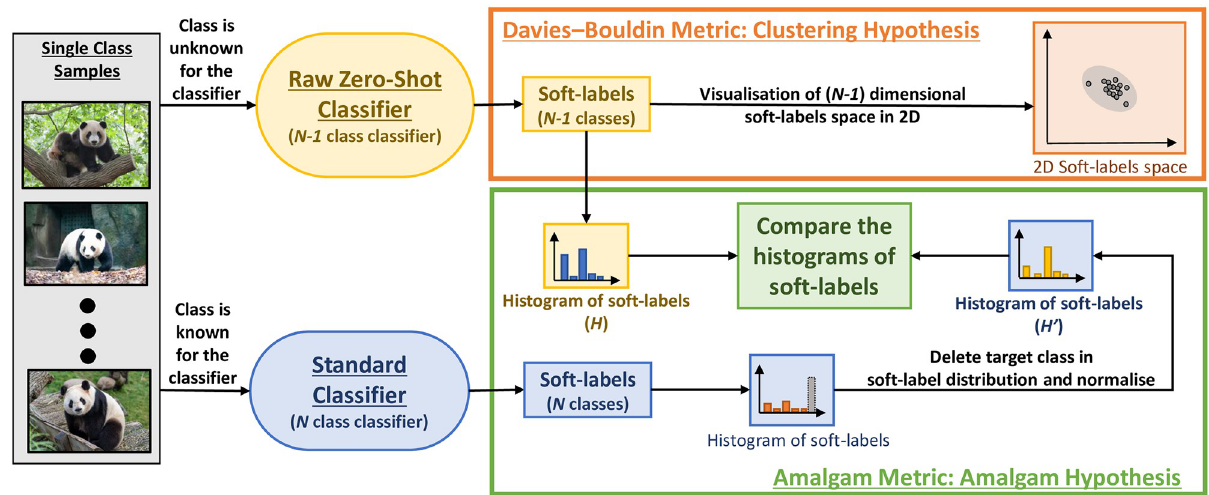
Fig 2. Illustration of proposed metrics, a) Davies–Bouldin Metric (DBM), and b) Amalgam Metric (AM). Here, we use a neural network’s last layer (classification layer) to evaluate the transferability-of-features from known classes to an unknown class. A network with good transferability-of-features would have a consistent view of the unknown class and form a dense